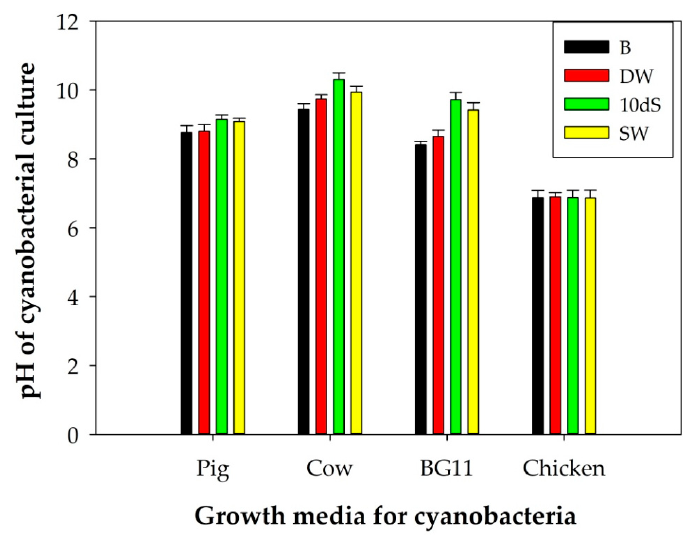
Figure 4. pH of cyanobacterial culture media before and after cyanobacterial growth. Pig = pig manure, cow = cow manure, chicken = chicken manure, B = each manure before cyanobacteria were cultured, DW = distilled water, 10 dS = diluted seawater at an EC of 10 dS/m, and SW = seawater. The error bars represent standard deviations (SDs). The data are the mean of three replicates.